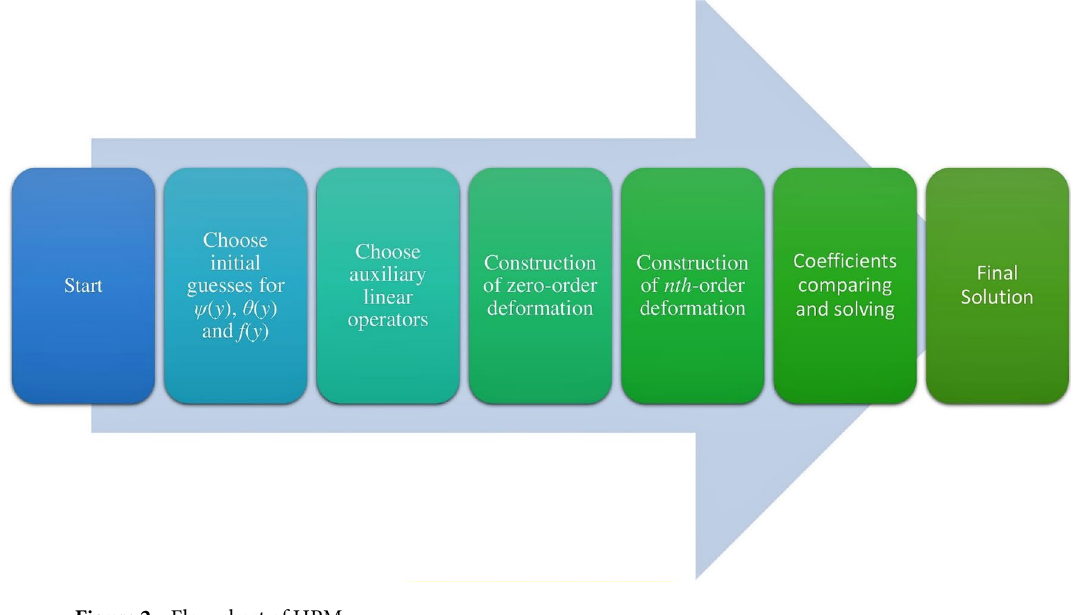
Figure 2. Flow chart of